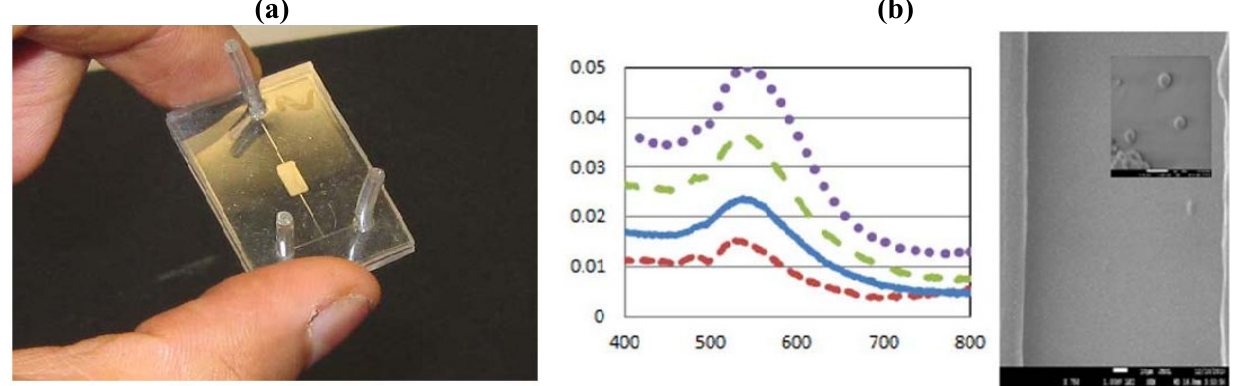
Figure 32. Fabrication of Au—PDMS nanocomposite through the reduction of Au ions inside the microfluidic channel. PDMS microfluidic device. ( a ) Dependence of the absorbance of Gold LSPR band on the time of reaction; and ( b ) SEM image of Au nanoparticles formed in the channel